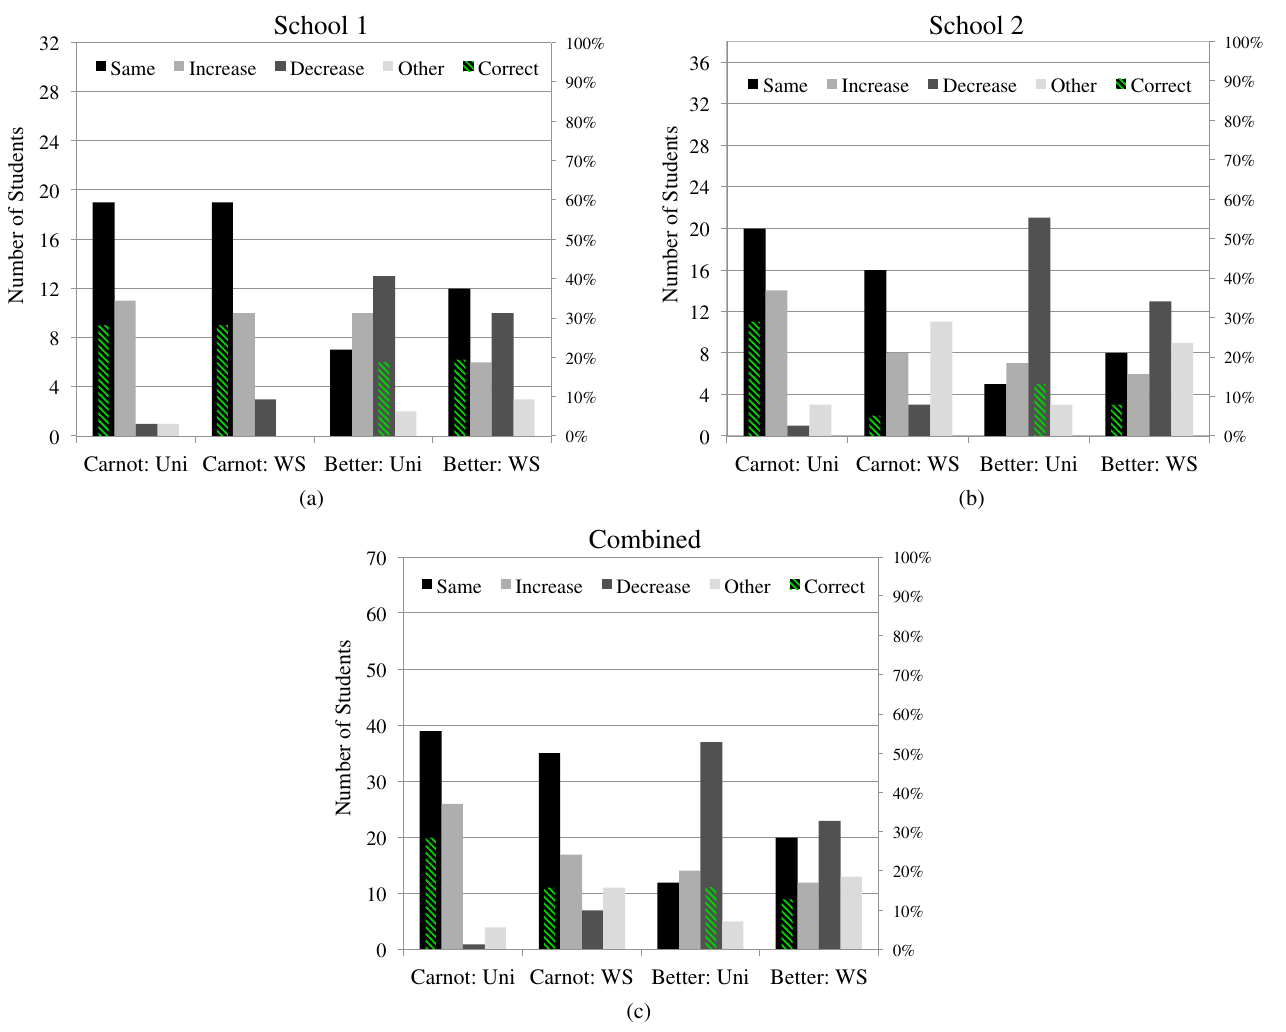
FIG. 2. Response frequencies on the EEQ pretest at (a) school 1 ( N ¼ 32 ), (b) school 2 ( N ¼ 38 ), and (c) school 1 and school 2 Combined ( N ¼ 70 ). Green diagonally striped bars indicate students who used correct reasoning. Only four students (two from each school) answered all four parts of the EEQ using correct reasoning. The “ Carnot ” labels refer to questions about the Carnot engine, the